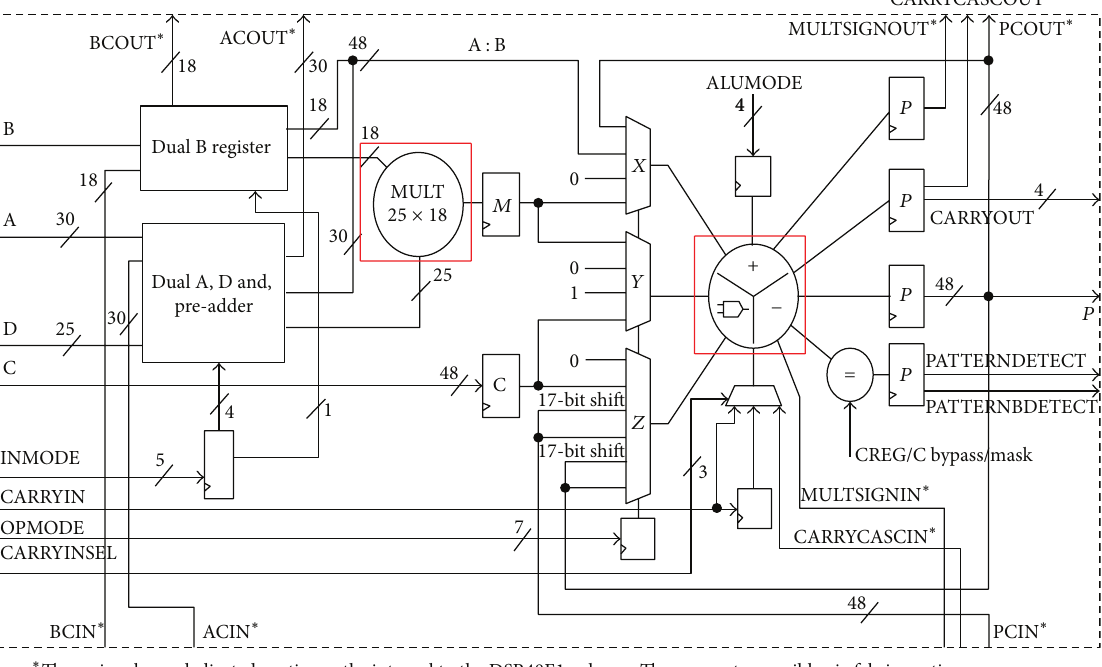
Figure 4: DSP48E1 architecture in Xilinx Virtex-6